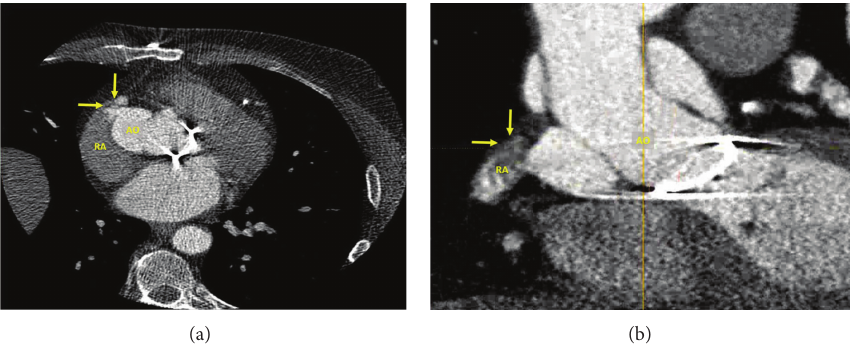
Figure2: CardiacCTscandemonstratesacontrastshuntwithinthewrapped portionofaorta withtherightatriumduringventricular